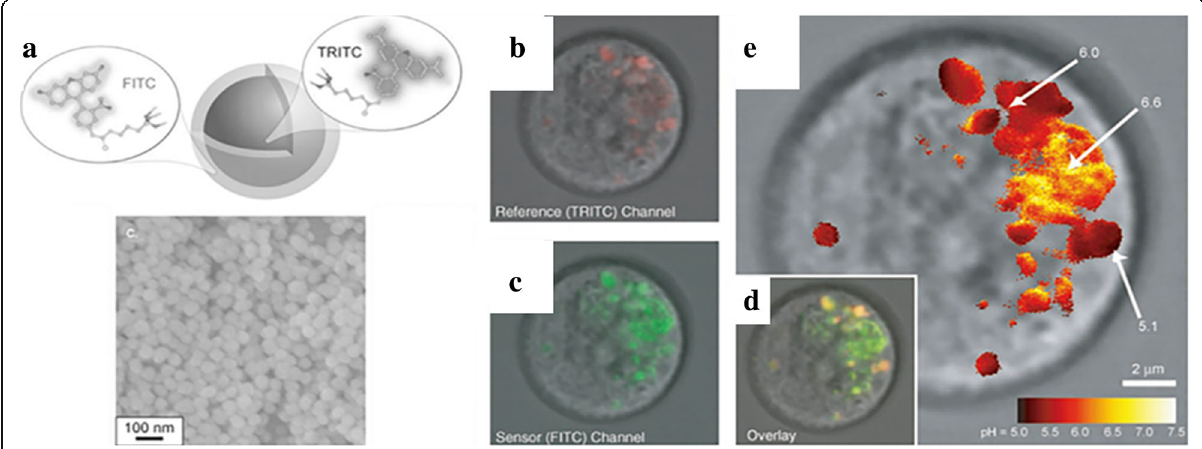
Fig. 1 a The formation diagram and scanning electron microscope (SEM) image of dual-emission fluorescent silica nanoparticles with reference dye (TRITC) and sensor dye (FITC); the confocal fluorescence microscopy image of RBL mast cells (red as TRITC silica particles and green as AlexaFluor 488-Cholera toxin B); confocal fluorescence microscopy images of RBL mast cells as pH sensors. b For reference channel, c for sensor channel, d for the overlaid images, and e false-color ratiometric imaging for pH values calculated according to the experiments